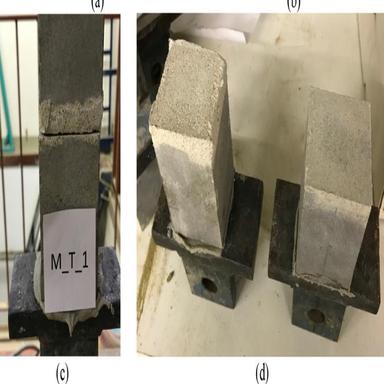
Specimens used to characterize the bond behavior between mortar and stones through direct tensile tests: (a) specimens tested; (b) direct tensile tests performed; (c) crack pattern at failure: (d) detail of the detachment interface.